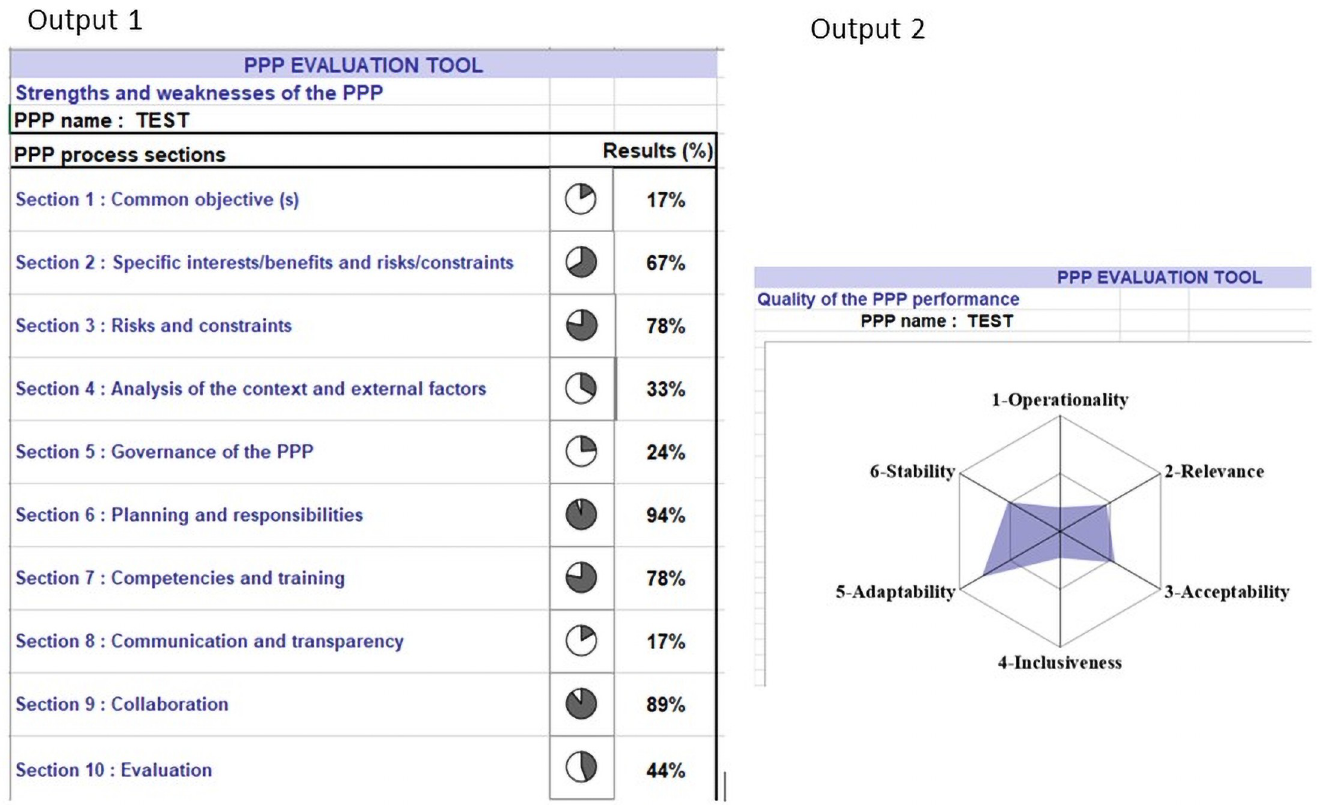
Fig 3. The two graphic outputs of the evaluation tool for the public-private partnership process. Graphic output 1 is a set of pie charts (the assessment of the sections), making it easy to identify the strengths and weaknesses of the process. Graphic output 2 is a spider chart (the assessment of the quality attributes), representing the influence of the process on the quality of the public-private partnership performance. The scores of the evaluation criteria have been randomly assigned.